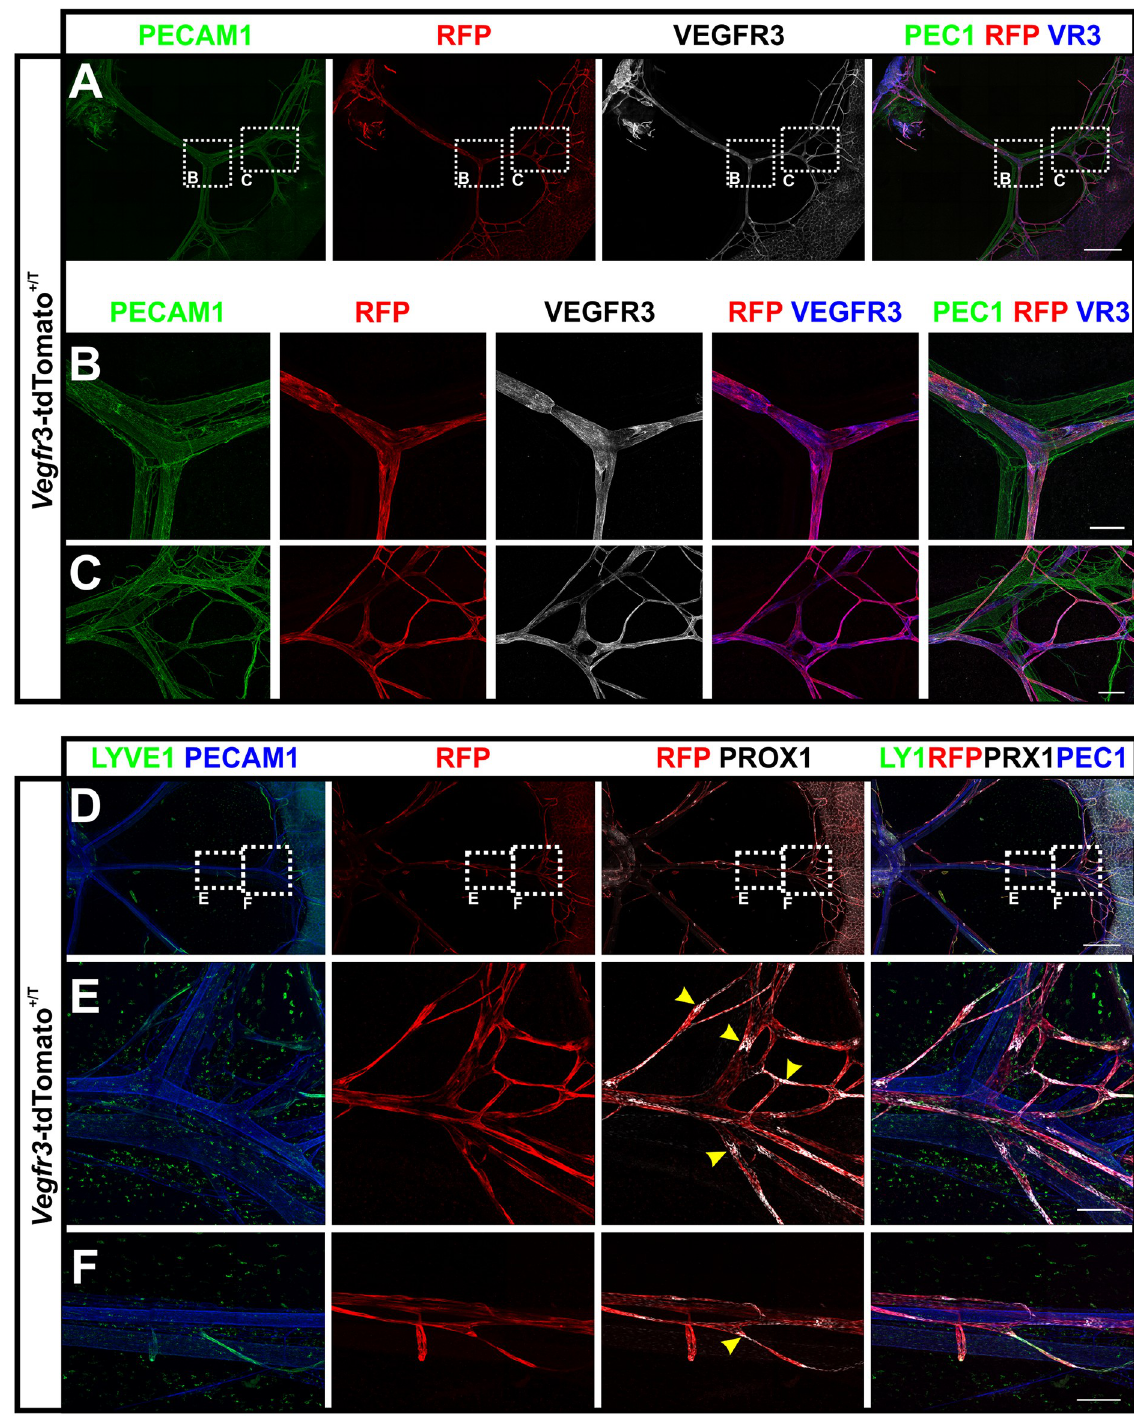
Fig 4. Lymph vessel-specific expression of the Vegfr3 -tdTomato transgene in the mesentery. A-F) Wholemount immunostained preparations of mesenteries from Vegfr3 -tdTomato transgenic pups at P5. Shown are MIPs of multi-tile z-stacks stained for the antigens depicted in colour above each panel. Magnifications of the areas boxed in white dashed lines in (A) and (D) are shown in the indicated panels (B,C and E,F). RFP staining identified transgene expression in lymphatic vessels. Yellow arrow heads indicate formation of semilunar valves. Scale bars = 1000 μ m (A, B), 200 μ m (B-C, E-F).